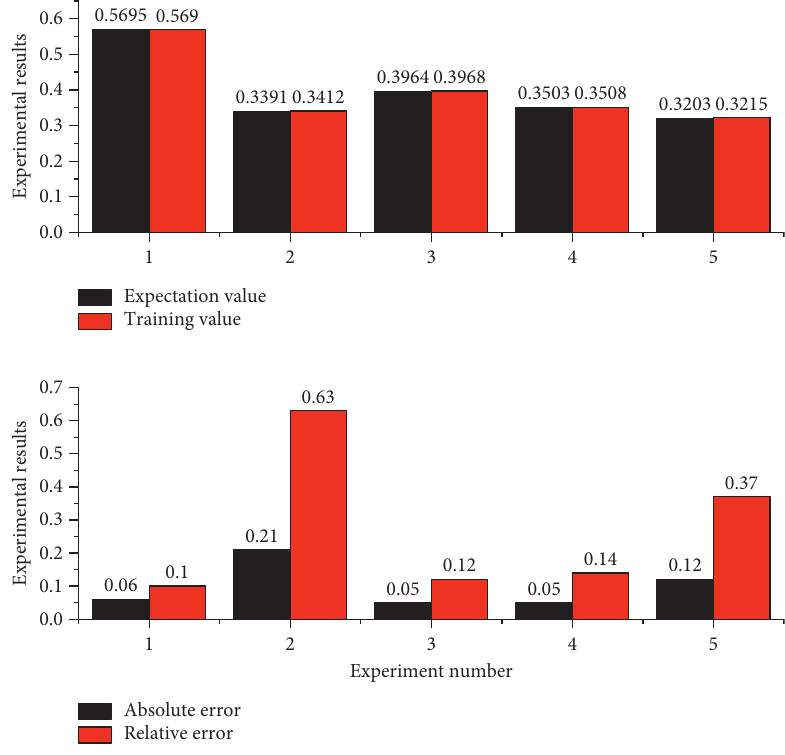
Figure 8: Expected output values versus training output